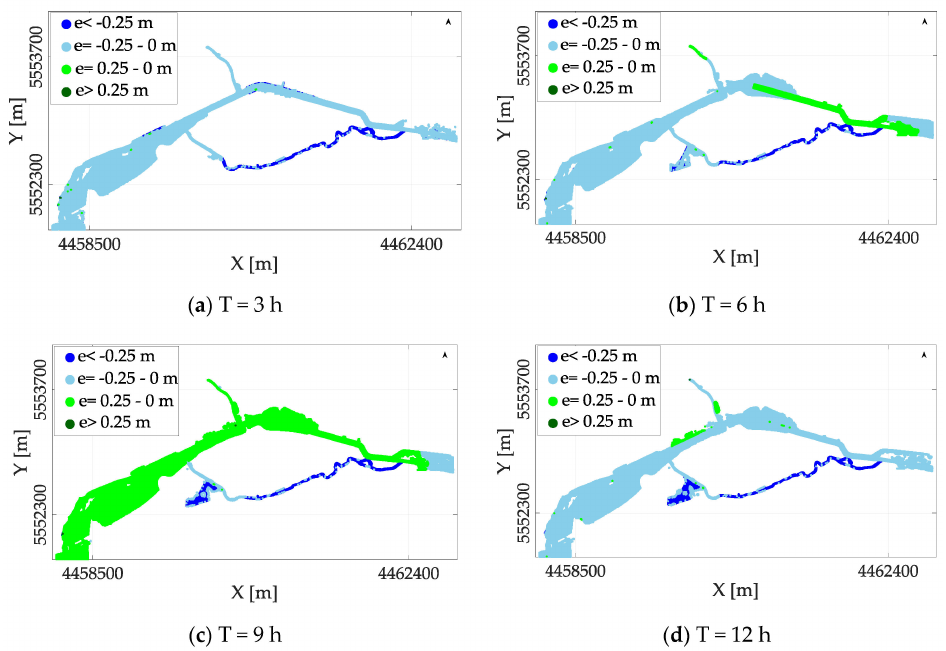
Figure 10. Water depth error between offline and online maps for May 2013: ( a ) T = 3 h, ( b ) T = 6 h, ( c ) T = 9 h and ( d ) T = 12